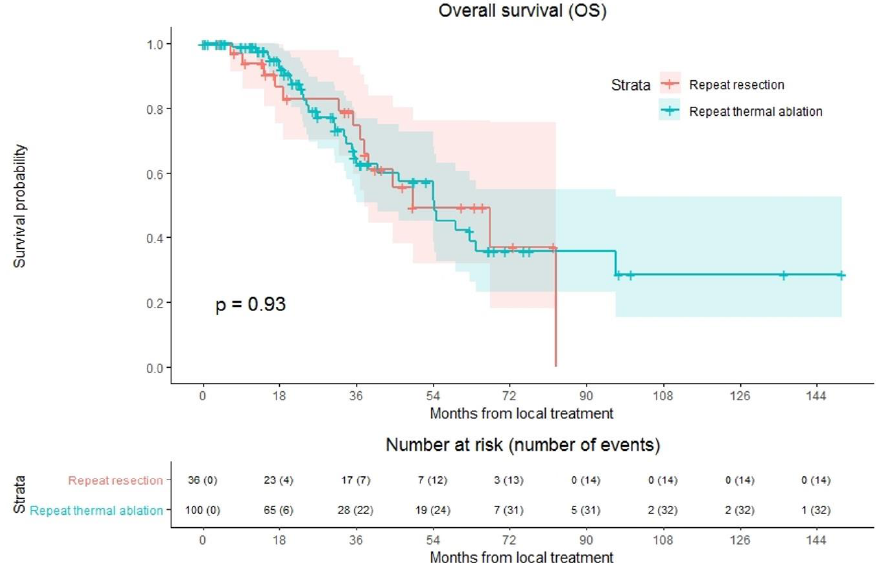
Figure 4. Kaplan–Meier curves of overall survival (OS) after repeat resection (red) and repeat thermal ablation (green). score, BMI = body mass index, * = insufficient subgroup size for each treatment group. Numbers at risk (number of events) are per patient. Overall comparison log-rank (Mantel-Cox) test, p = 0.927. Table 4. Univariable and multivariable cox regression analysis to detect potential confounders associated with overall survival (OS). After removal of primary tumor location and adjusting for the confounder comorbidities, corrected HR of repeat local treatment was 0.986 (95% CI, 0.517 – 1.881; p = 0.966).